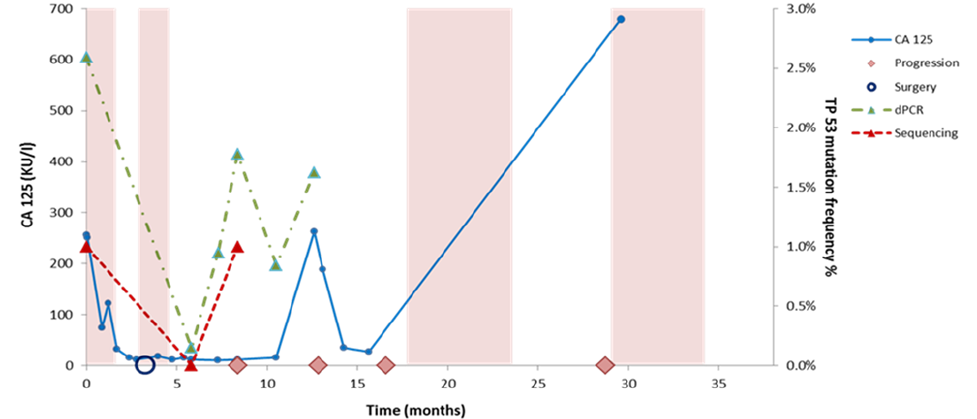
Figure 3. Monitoring cfDNA and CA125 levels over time in patient 5. Disease monitoring by CA125 levels and TP53 mutation (p.K132R) levels determined by NGS and digital PCR in patient 5. The colored boxes indicate time on treatment with chemotherapy. The graphs show the change in CA 125 (KU / l) levels and TP53 mutant allele frequencies (VAF %) in serial serum samples. The somatic mutations were measured using dPCR and Ion Torrent Sequencing. The timeline (in months) is indicated on the x-axis, the allele frequency of the identified mutations is represented on the right y-axis, while the CA 125 level is indicated on the left y-axis. The recolored boxes depict the times on treatment with chemotherapy. Surgery is indicated with a blue circle while clinical observed disease progression is depicted with a pink rhombus.